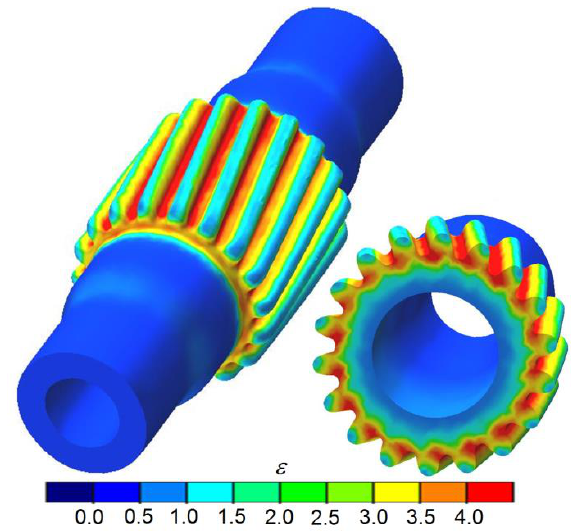
Figure 6. FEM-modeled shape of the gear formed on the shaft and the distribution of effective